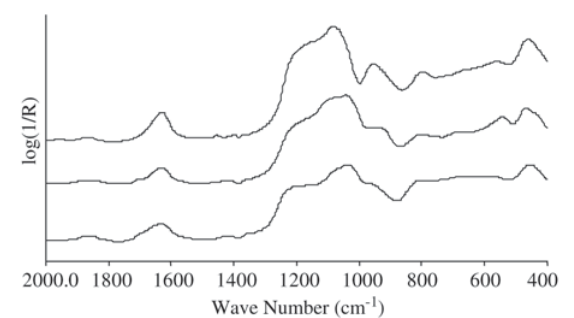
Figure 1. DRFTIR spectra of STA samples treated at 110 °C, 600 °C and 800 °C (top to bottom).